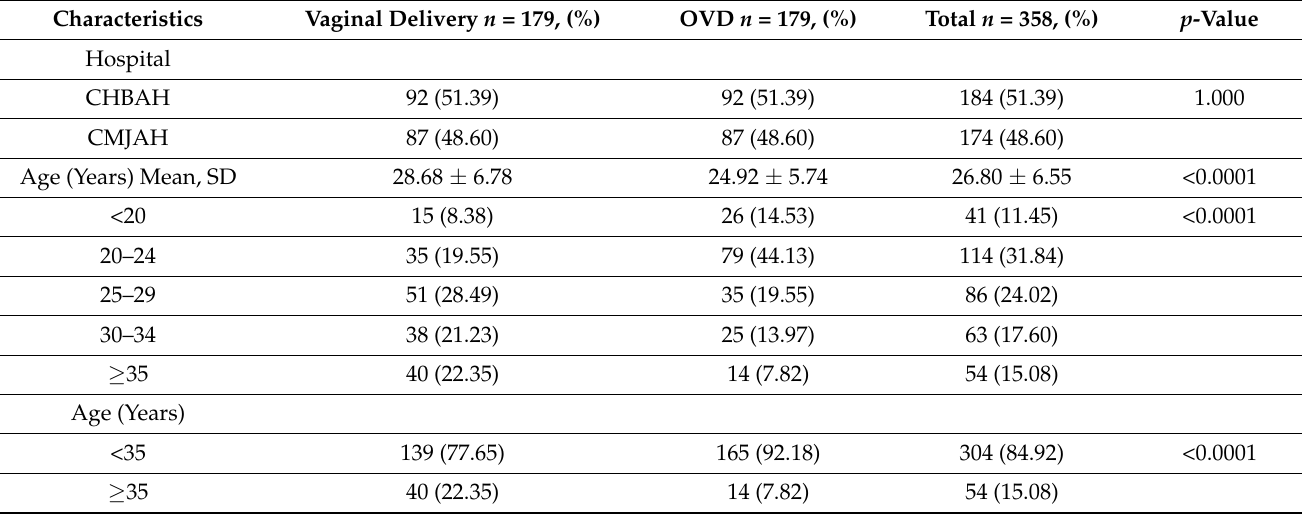
Table 2. Comparison of the socio-demographic characteristics of patients who had vaginal delivery and those who had operative vaginal delivery from the two academic hospitals. In